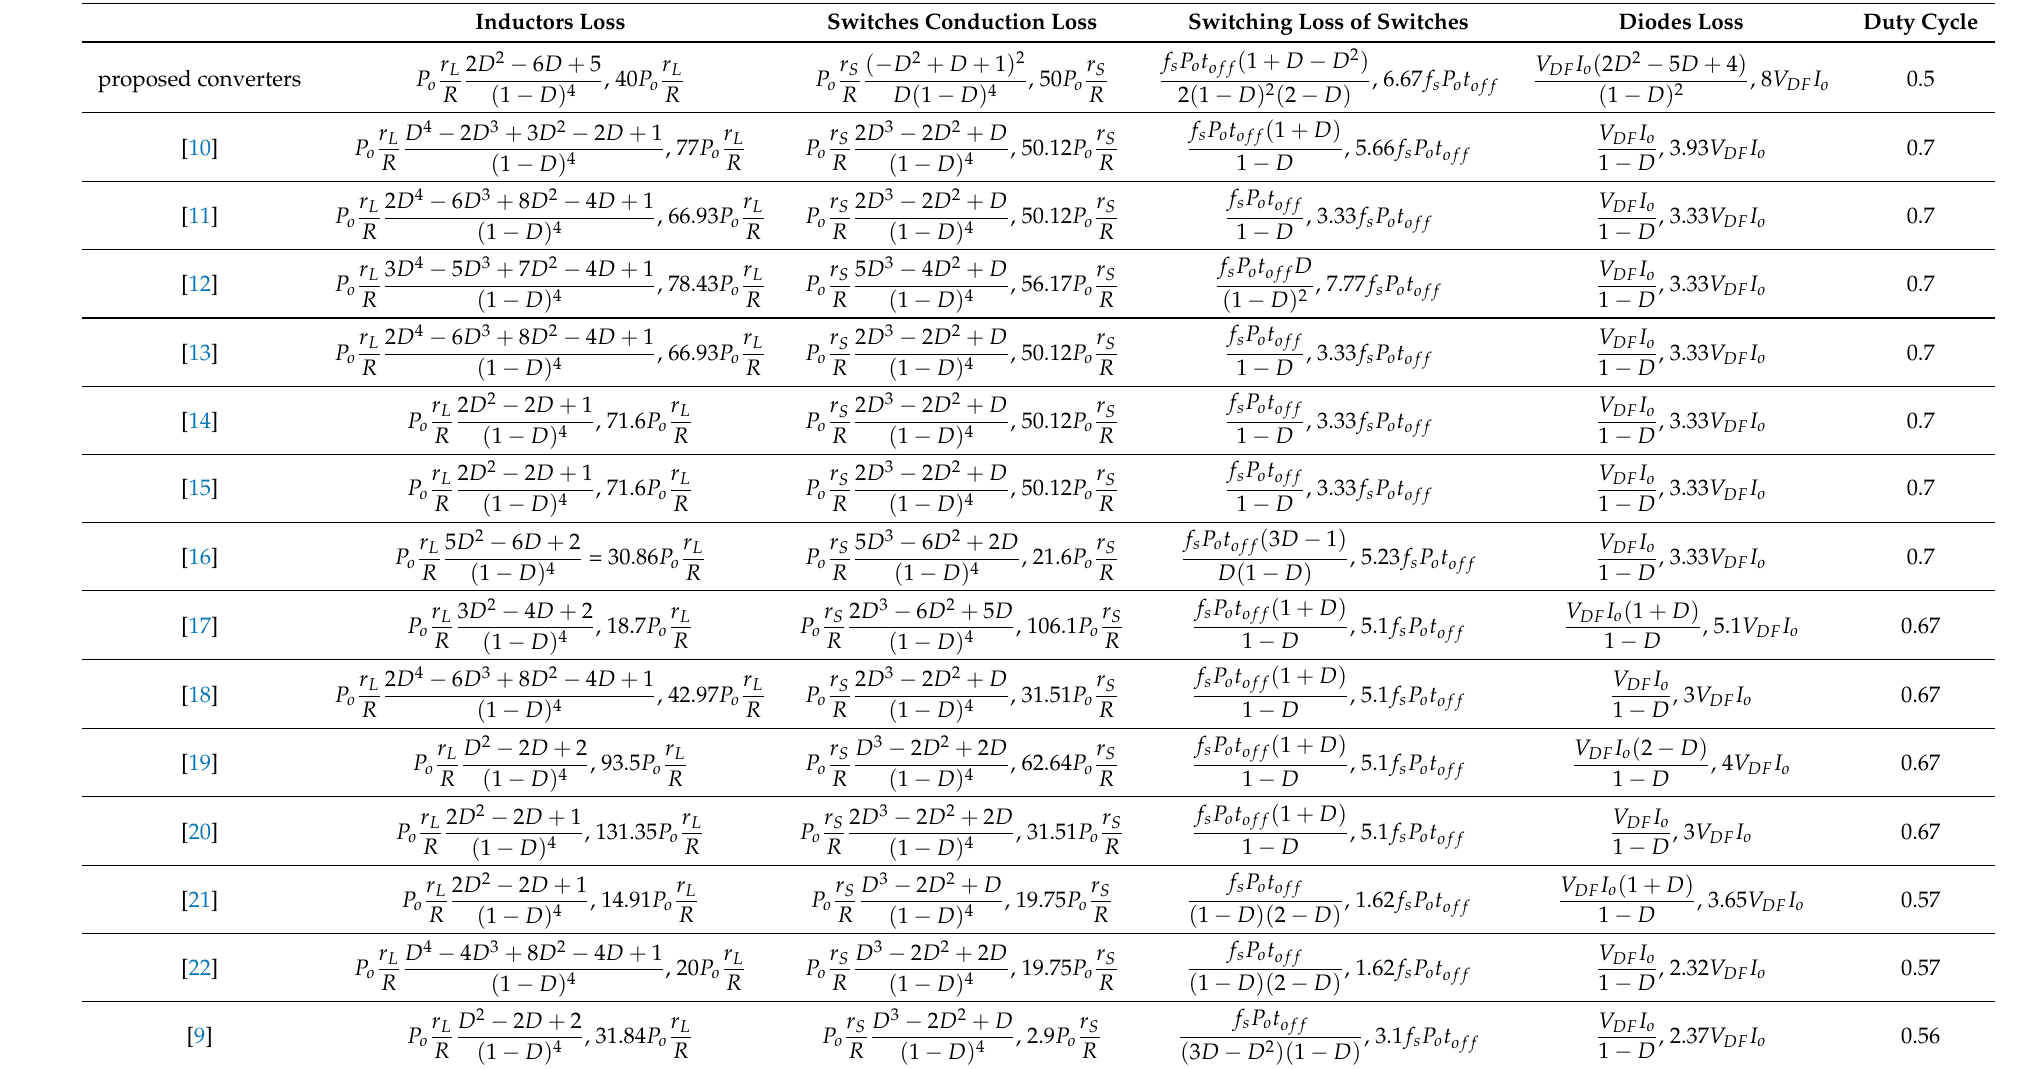
Table A2. Comparison of the power